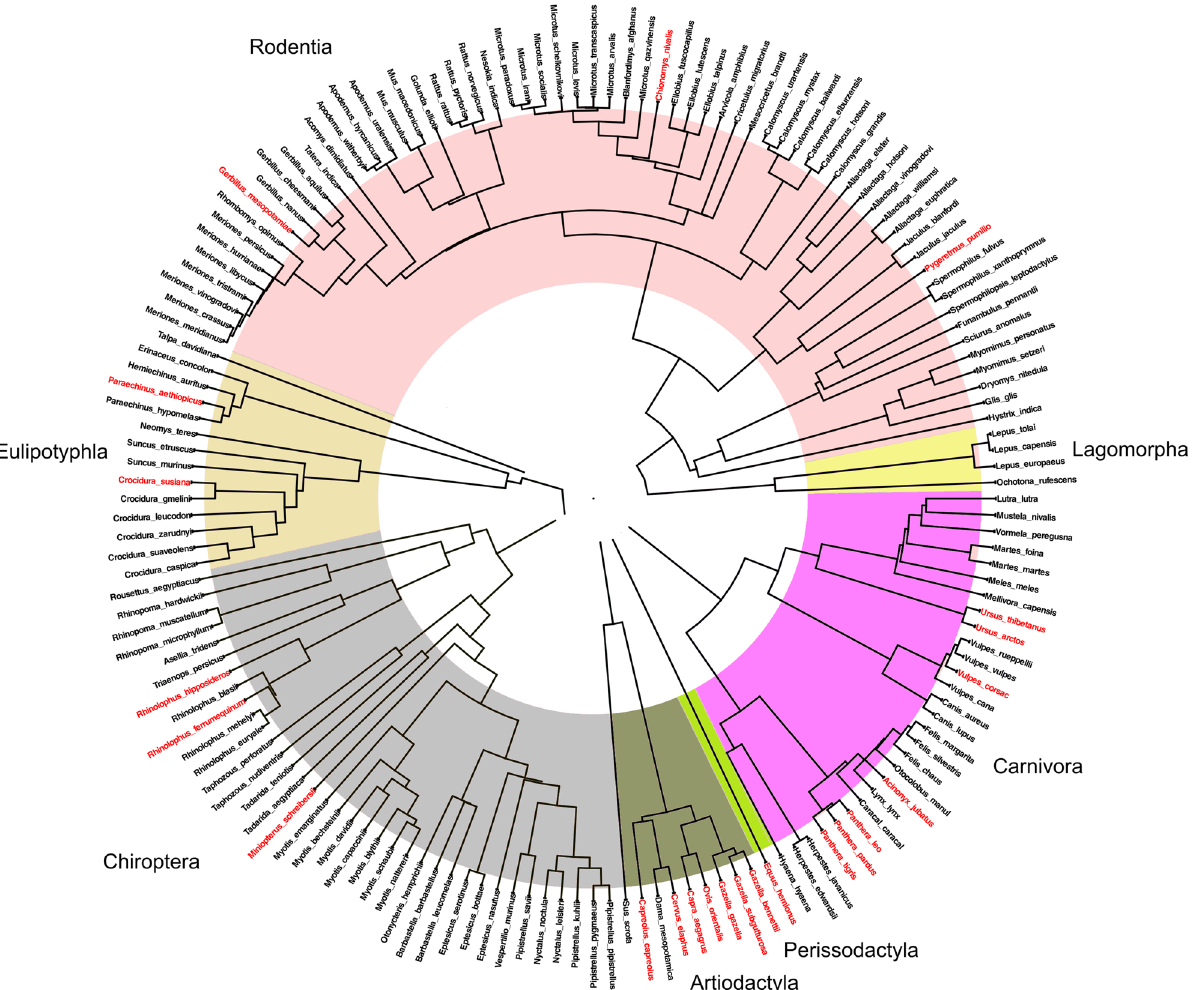
Figure 2. Phylogenetic tree of the 156 mammal species belonging to seven orders and 31 families used in the comparative analysis. The colour of the labels (scientific names) of the tree show threatened (red colour) and non-threatened (black colour) species. The phylogeny is built based on a modification of the species-level supertree of mammals generated by 43 dataset and overlaid with the EOO for each species (Supplementary Table S1 and Fig. S2). The species-specific mean HII experienced by each species was calculated using ‘raster’ 51 , ‘rgdal’ 52 , and ‘maptools’ 53 R packages. As a measure of extinction risk, we followed previous studies (e.g., 22 ) in the use of classifications based on IUCN status categories. The IUCN status categories of the 179 species (Supplementary Table S1) were taken from a recent conservation assessment (Fig. 3) 13 . We used the national status rather than global status, because regional IUCN Red List is considered more suitable when developing regional-scale analyses, as regional status should reflect more accurately the extinction risk within a country 19 . Excluding species with unknown threat status (Data Deficient), a total of 156 species belonging to seven orders and 31 families categorised from Least Concern to Regionally Extinct as a continuous character (from 0–5 in increasing order of relative risk, following Fritz et al. 21 ), were available for analyses (see details in Supplementary Table S1). Given that IUCN uses small geographical range for listing species as threatened (criterion B), the species’ range size was excluded from the analyses to avoid circularity 54 . Statistical analyses. We first tested for evidence of phylogenetic non-independence in the model residuals